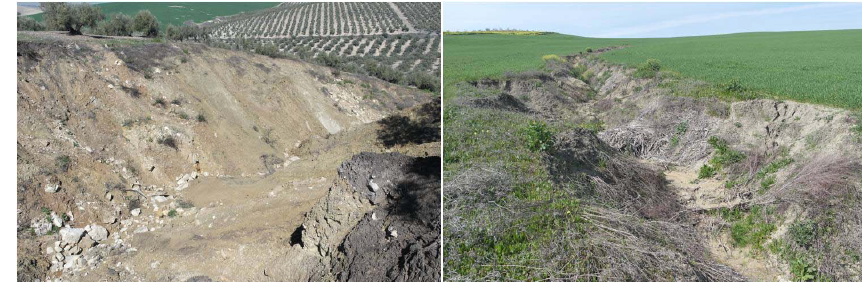
Figure 2. Typical gullies in olive orchards (left panel) and in herbaceous crops (right panel) in the study zone.